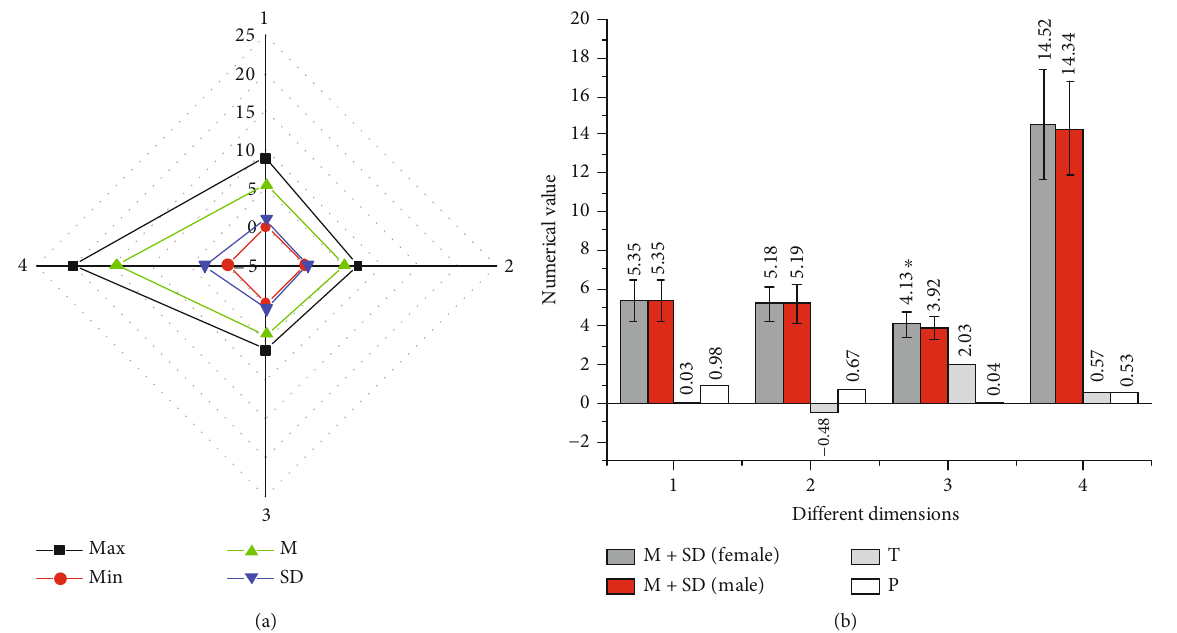
Figure 12: Overall situation and di ff erence of mental health of college students: (a) descriptive statistics of mental health in general; (b) di ff erences in di ff erent dimensions of mental health; 1: self-a ffi rmation; 2: nondepression; 3: mental health; ∗ P < 0 : 05